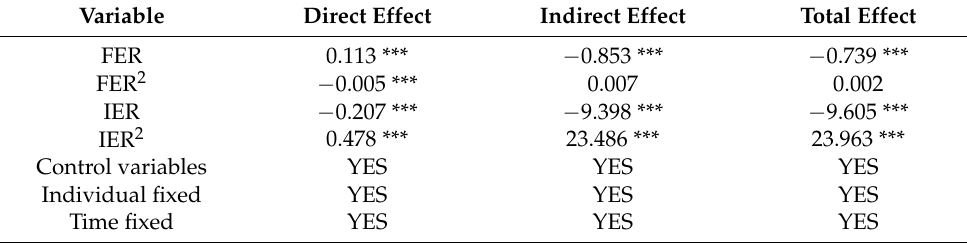
Table 6. Decomposition of spatial